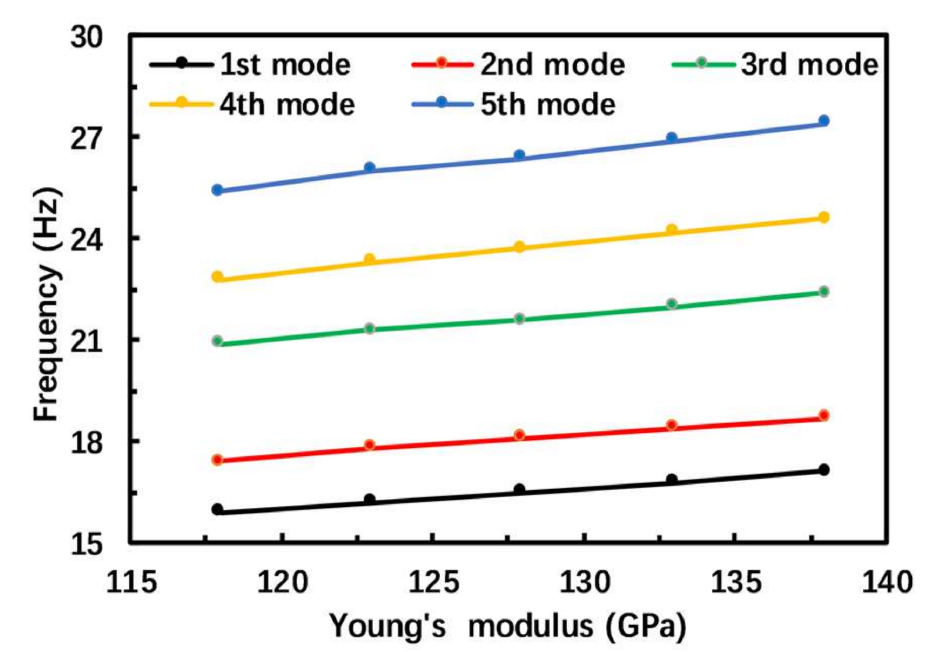
Figure 8. The influence of the Young’s modulus of the substrate on the resonance frequencies.